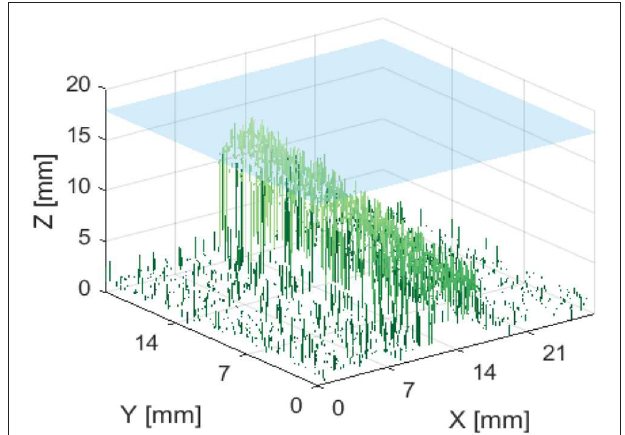
FIGURE 14 | Reconstructed depth map for a capillary phantom inclined at 15 ◦ to the plane. Positioned so that the maximum height is 2mm below the surface of soft tissue emulate, shown in